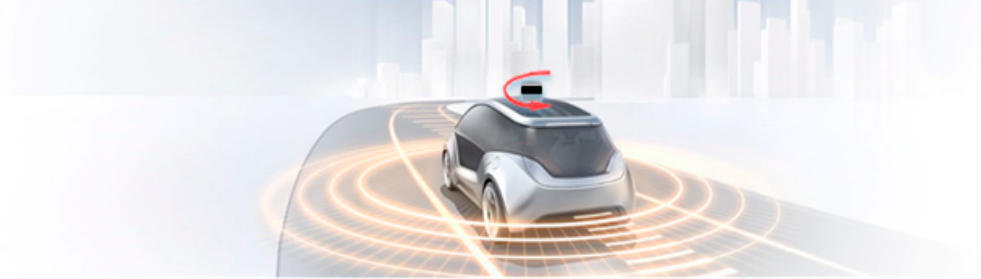
Figure 2. Example of a LiDAR sensor capable of 360° viewing angle working in constant rotation.